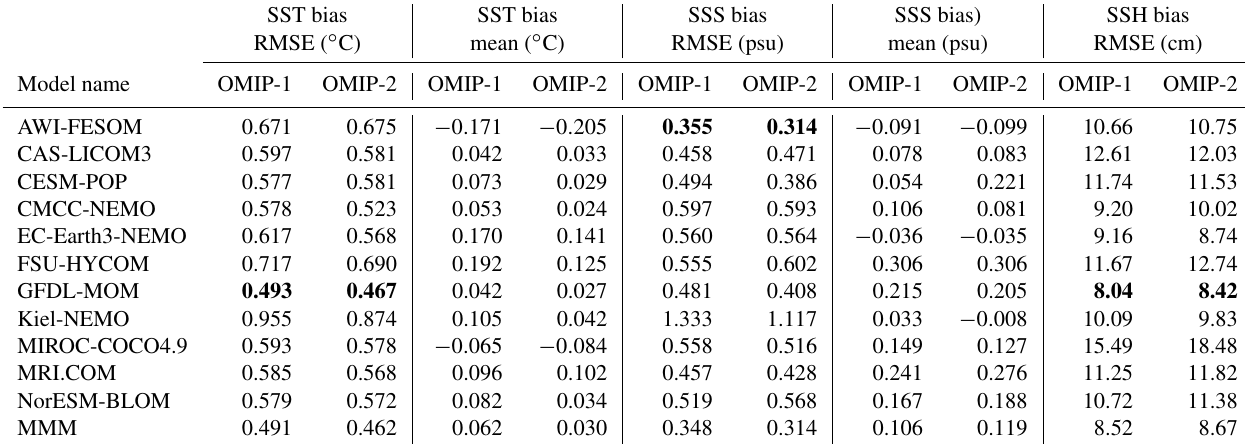
Table D3. Root mean square bias and mean bias of the 30-year mean (1980–2009) sea surface temperature ( ◦ C) and salinity (psu) relative to observations (PCMDI-SST and WOA13v2, respectively) and root mean square bias of the 17-year mean (1993–2009) SSH (cm) relative to observations (CMEMS) for individual models. The smallest root mean square bias values for models in each simulation are emphasized with bold